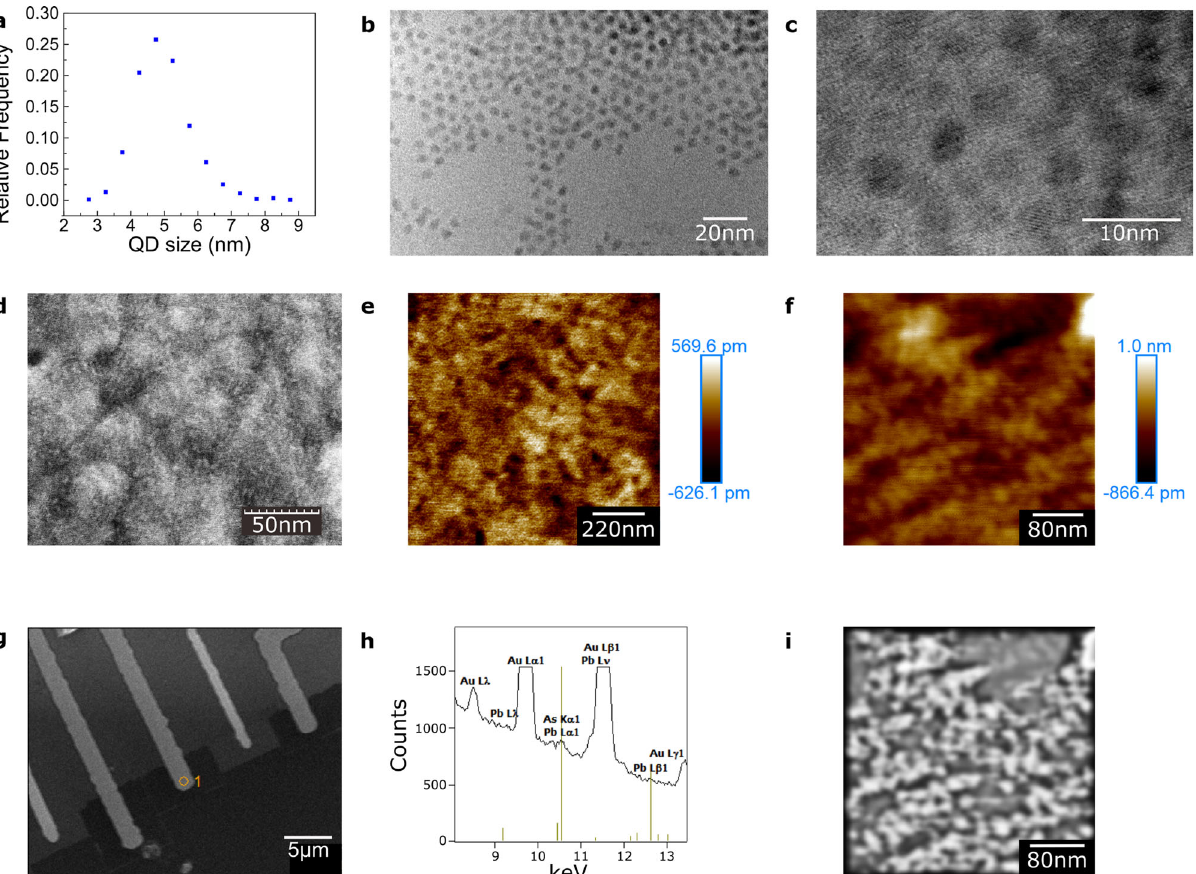
Fig. 4 Characterisation of quantum dots. a Normalised distribution of average widths of >1000 PbS QDs measured from TEM data taken after drop- casting QDs on to a TEM grid. μ = 5.0 nm, σ = 0.8 nm. b TEM image showing some of the QDs after drop-casting. c Calibrated image where the QD